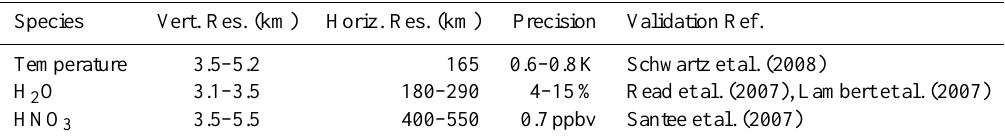
Table 1. Resolution and precision of selected MLS v3.3 data